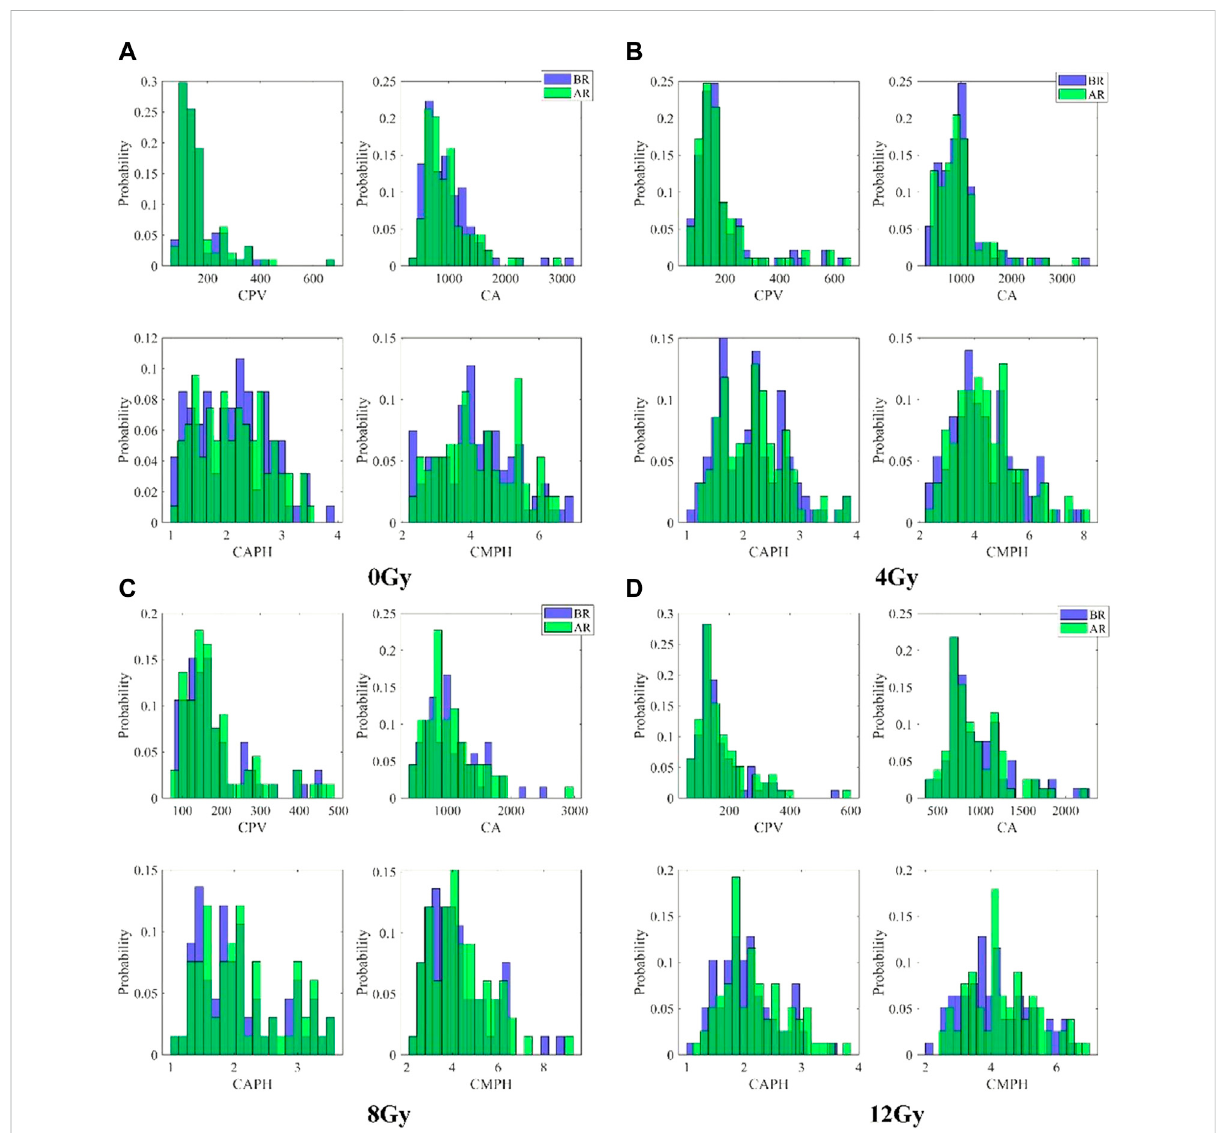
FIGURE 6 The distributions of CPV, CPA, CAPH, and CMPH of each group before and after radiation.